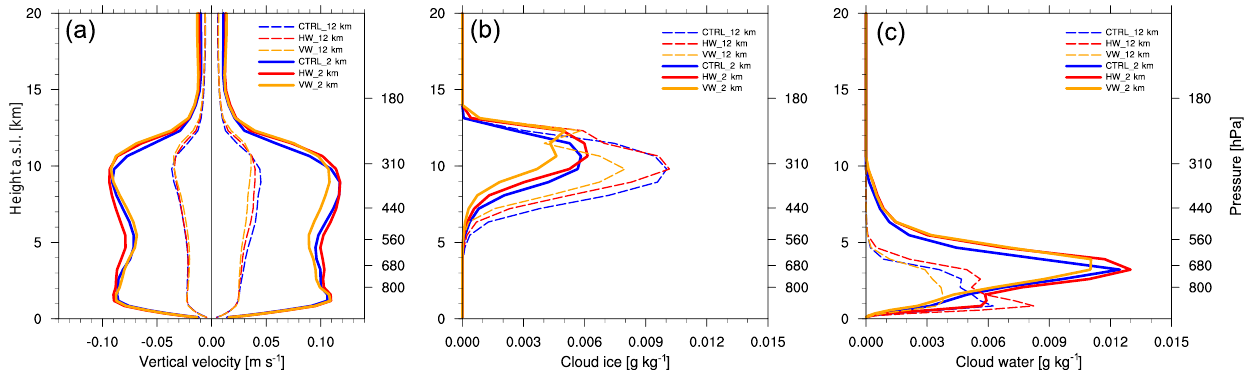
Figure 5. Vertical profiles of (a) grid-scale vertical velocity, (b) cloud ice content, and (c) cloud water content for six simulations, averaged horizontally over the analysis domain and temporally over all hours from 3 to 13 June 2007. Control runs are indicated in blue, HW runs in red, VW runs in orange, 12km runs with dashed lines, and 2km runs with solid lines. Vertical velocity is separated into averages of negative and positive values. Height is indicated in kilometers on the left-hand side and in hPa on the right-hand side of every